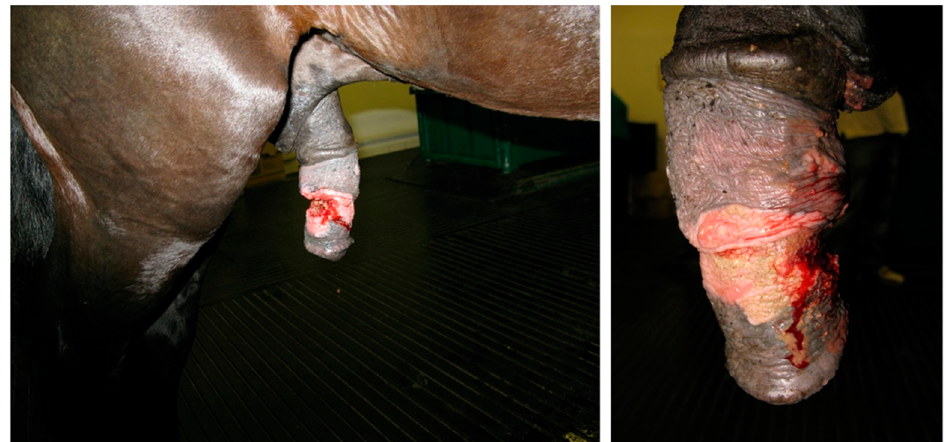
Figure 8. Penile/preputial wound on admission (clinical case 4).